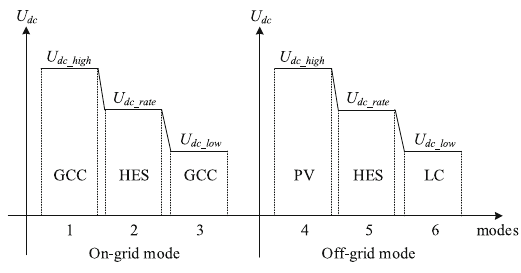
Fig. 8 Power control strategy for a household-level